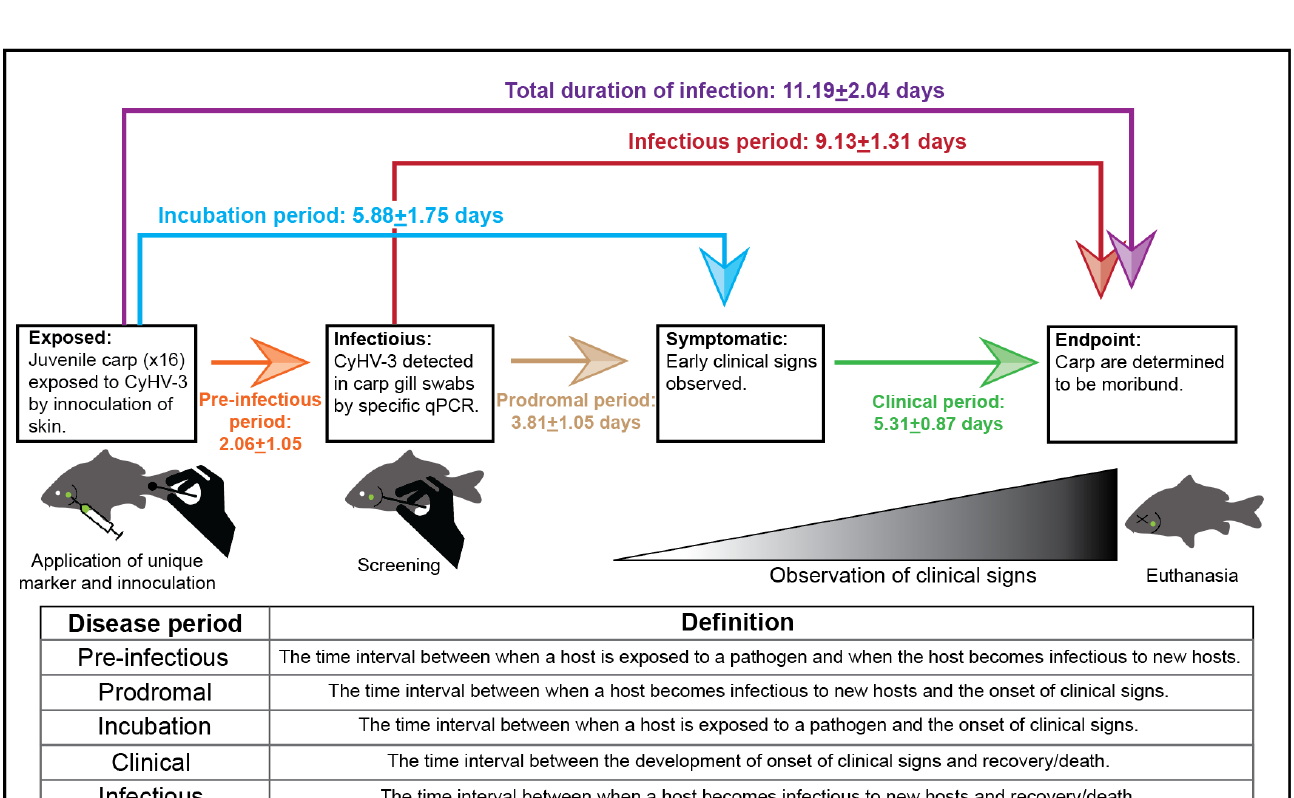
Figure 1. Trial 1 schematic and disease periods. Average values, standard deviations, and definitions are given for each CyHV-3 disease period.